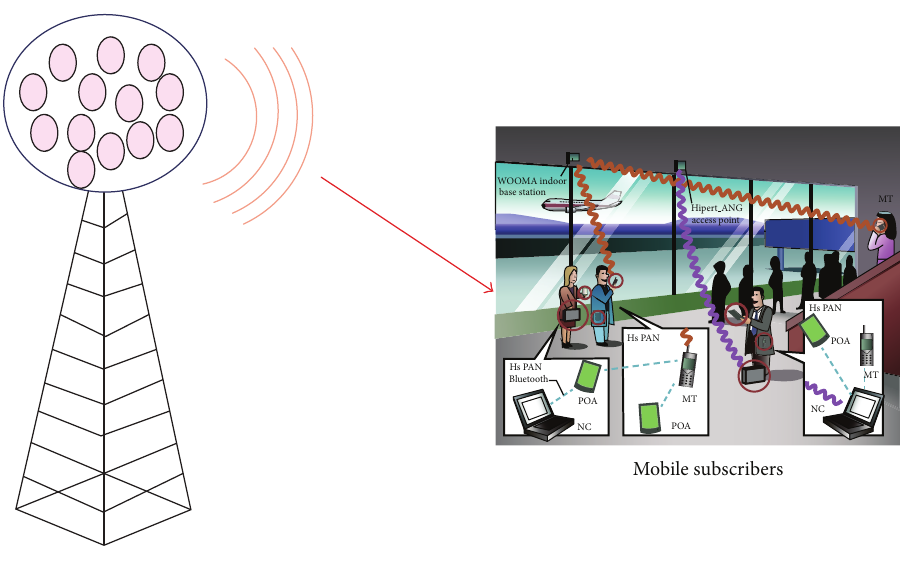
Figure 1: Large-scale MIMO communication system